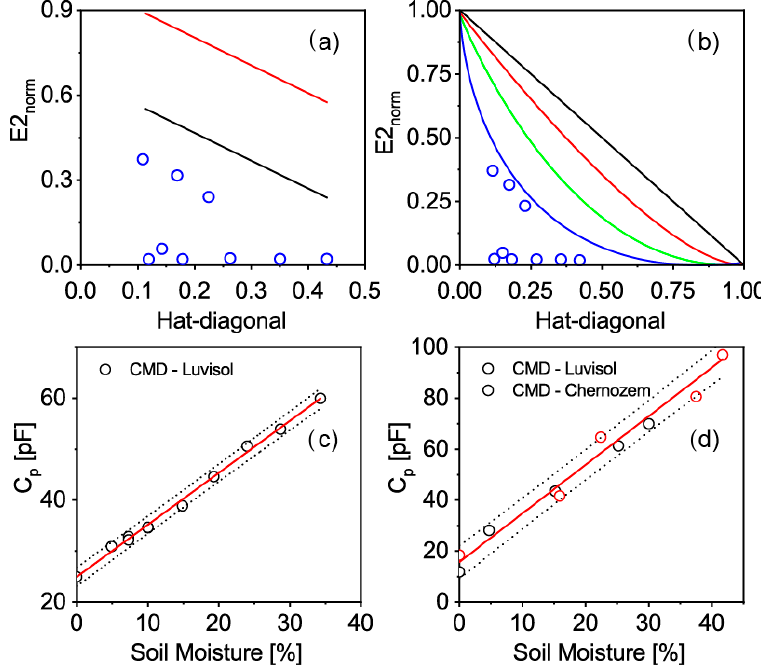
Figure 9. The residual analysis for CMD sensor element presented by ( a ) Pregibon, ( b ) the L-R plot after filtration. Regression analysis for CMD sensor elements response measured with IoT unit: ( c ) CMD on wood plank and ( d ) combined data for soil types Luvisol and Chernozem measured for CMD on FR4.